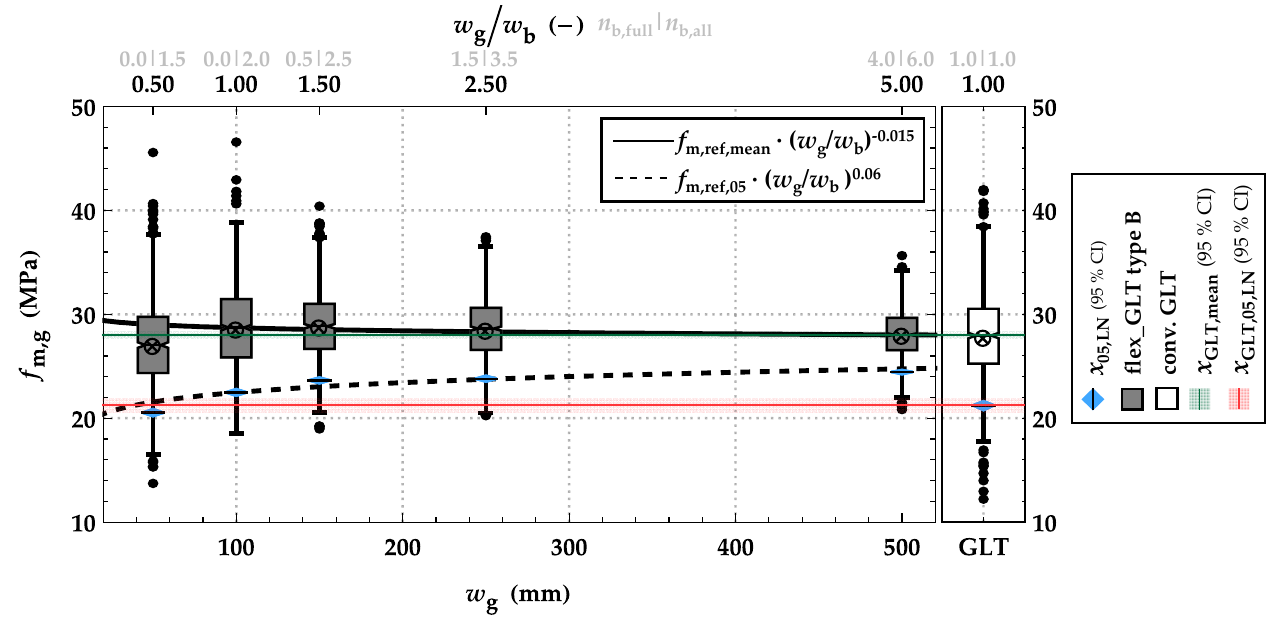
Figure 28. Boxplots together with mean and 5%-quantile values of the bending strength f m,g of flex_GLT type B beams featuring a depth of h g = 360 mm and different beam widths w g = {50; 100; 150; 250; 500} mm and conventional glulam (reference) of similar depth and width w g = 100 mm built up from boards of group GI (T14) with dimensions of w b = 100 mm and t b = 30 mm.